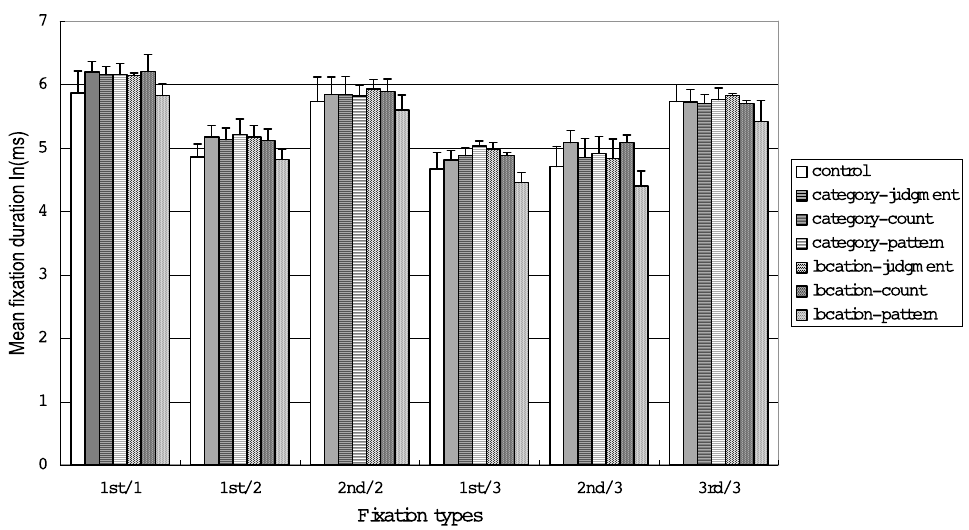
Figure 5. Mean fixation duration in task and control conditions in six fixation types. Mean of log-transformed fixation durations were plotted for each fixation type; from the left ,1st/1-fixation, 1st/2-fixation, 2nd/2-fixation, 1st/3-fixation, 2nd/3-fixation and 3rd/3- fixation, where nth/m-fixation means the n-th fixation from those trials in which m fixations to an object were made. Vertical lines indicate